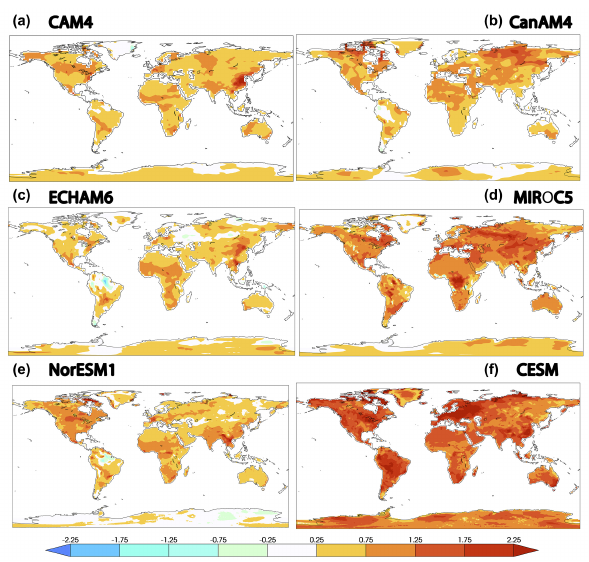
Figure 1. Change in 20-year return values ( ◦ C) between the 1.5 ◦ C and present-day HAPPI simulations of TX3x. (a) CAM4. (b) CanAM4. (c) ECHAM6. (d) MIROC5. (e) NorESM1. (f)